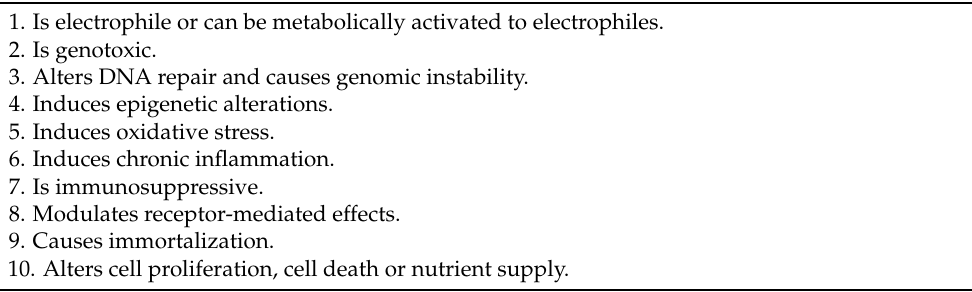
Table 1. List of the key characteristics of